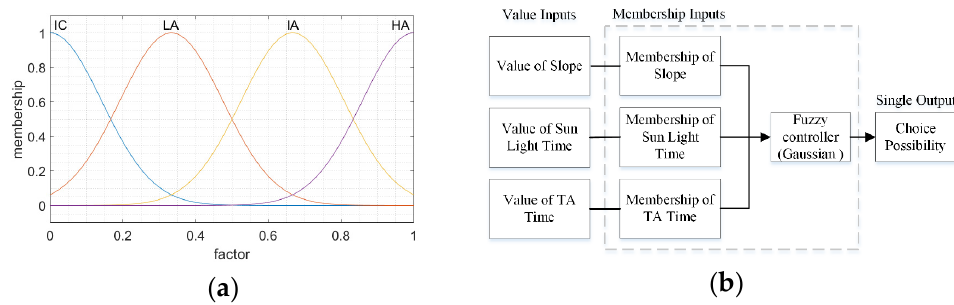
Figure 7. The diagram of ( a ) relation between the three factors and their memberships and ( b ) the MISO fuzzy controller.